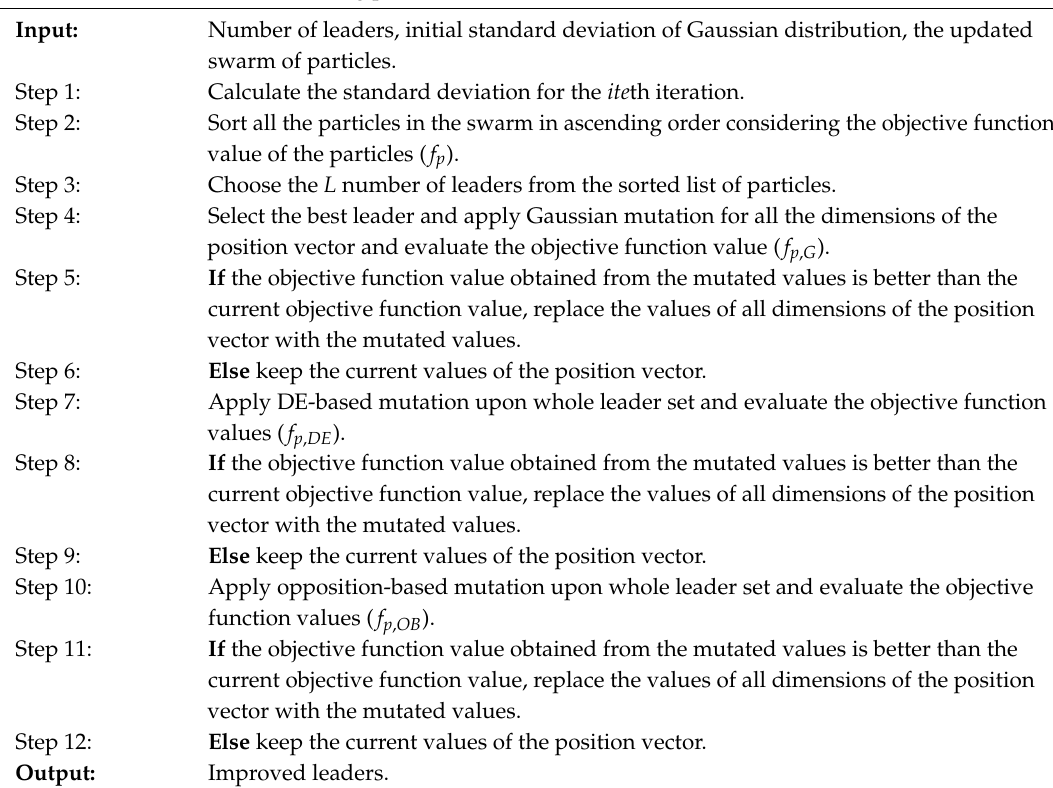
Algorithm 2. Leaders’ self-learning